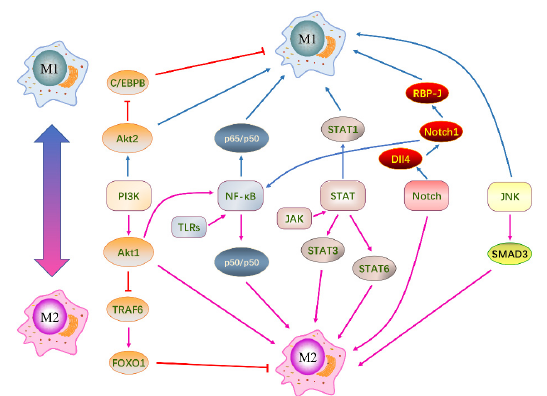
Figure 3. Signaling pathways associated with macrophage polarization. There are five primary signaling pathways: PI3K/AKT signaling pathway, TLRs/NF- κ B signaling pathway, JAK-STAT signaling pathway, Notch signaling pathway, and JNK signaling pathway. These pathways modulate macrophage polarization individually or in conjunction with others. Negative regulation between adjacent molecules is indicated by red lines, while positive regulation is represented by arrows. Molecules that promote macrophage polarization toward the M1 phenotype are depicted by blue arrows, and those that promote M2 polarization are shown by pink